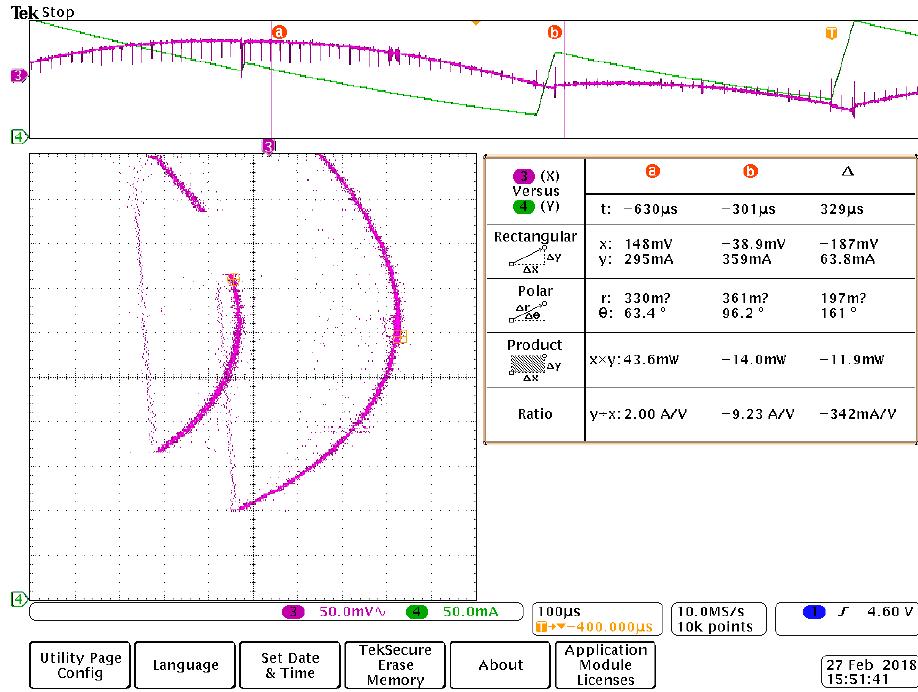
Figure 17. Phase portrait for V g = 16.50 V, confirming stable operation.